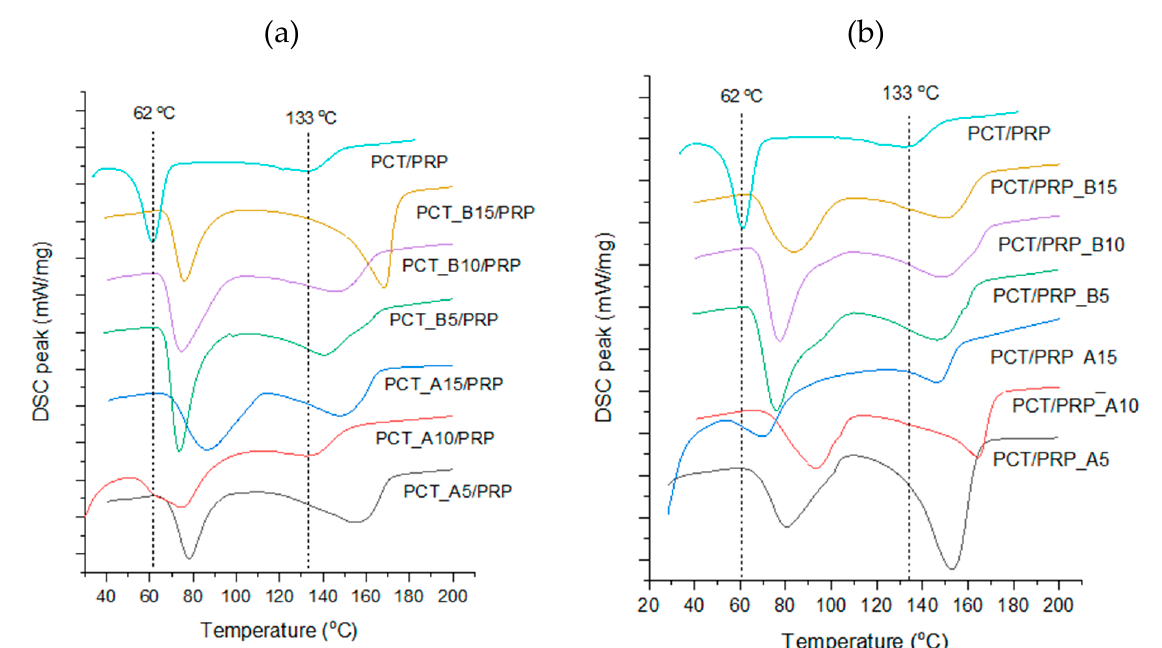
Figure 4. DSC thermograms of ( a ) co-spray dried paracetamol (PCT), and ( b ) co-spray dried propyphenazone (PRP) alone with the two studied polymers (dotted lines correspond to melting points of pure drugs).